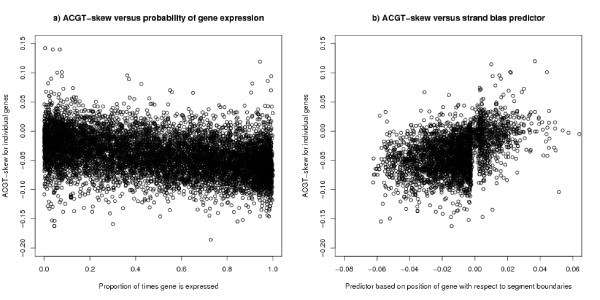
ACGT-skew for individual genes – long genes. The y-axis is the ratio ((A+C)-(T+G))/(A+C+G+T)) for introns (and also excluding the 50 bases at each end of the intron) as used in [16]. The plot is restricted to genes of at least 10 k bases. a) ACGT-skew for individual genes by proportion of times gene is expressed: The plot shows a correlation of -0.39 (n = 8352). Even for seldom expressed genes there is an average negative bias. b) ACGT-skew for individual genes by segment bias predictor: The plot excludes genes which extend more than 100 k bases from both A+/T+ and T+/A+ boundaries, and this explains the gap in the plot. The correlation is 0.43 (n = 9040). The predictor does not use any information about transcription other than the position of the gene with respect to the segment boundaries. In particular, no information about transcription bias is used in calculating the predictor.